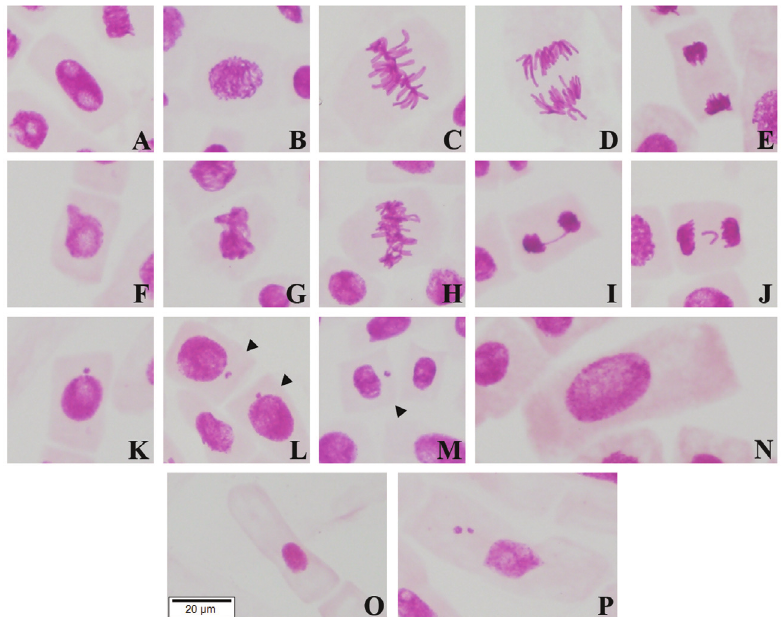
Figure 2 - Alterations observed by the A. cepa test system analysis. As the treatments with EEGP and EEBD did not induce statistically significantly chromosomal aberrations and micronuclei, these pictures were obtained by the positive control treatment (PC-MMS). A. normal interphase; B. normal prophase; C. normal metaphase; D. normal anaphase; E. normal telophase; F. interphase with a nuclear bud; G. metaphasis with chromosomal adherence; H.polyploidmetaphase;I.telophasewithachromosomalbridge;J.telophasewithachromosomalloss;K-M.interphasewithmicronucleus;N.polyploid interphase; O. normal F1 generation cell; P. F1 generation cell with